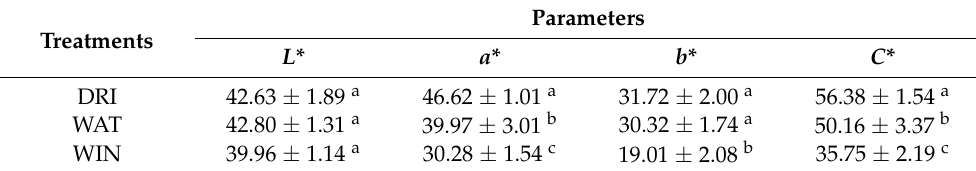
Table 2. Color parameters of LBL with different